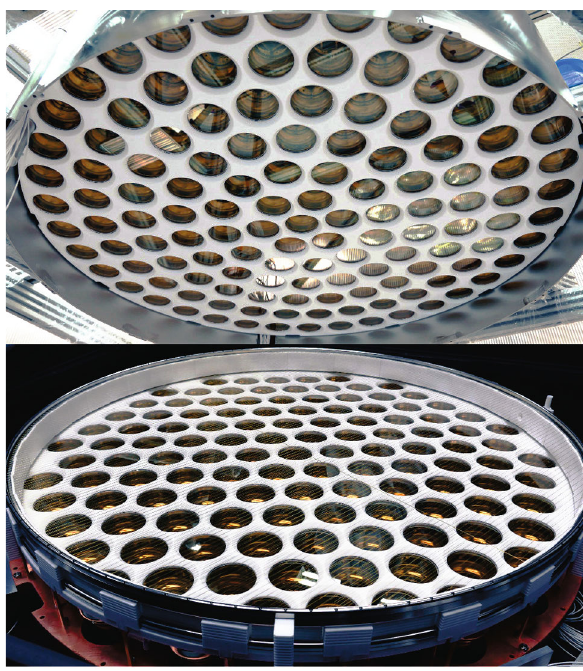
Fig. 4 The top and bottom PMT arrays are equipped with 127 and 121 Hamamatsu R11410-21 tubes, respectively. The top array is installed inside a diving bell, used to maintain and precisely control the LXe level. The bottom image also shows the cathode and the bot- tom screening electrode, installed in front of the PMTs